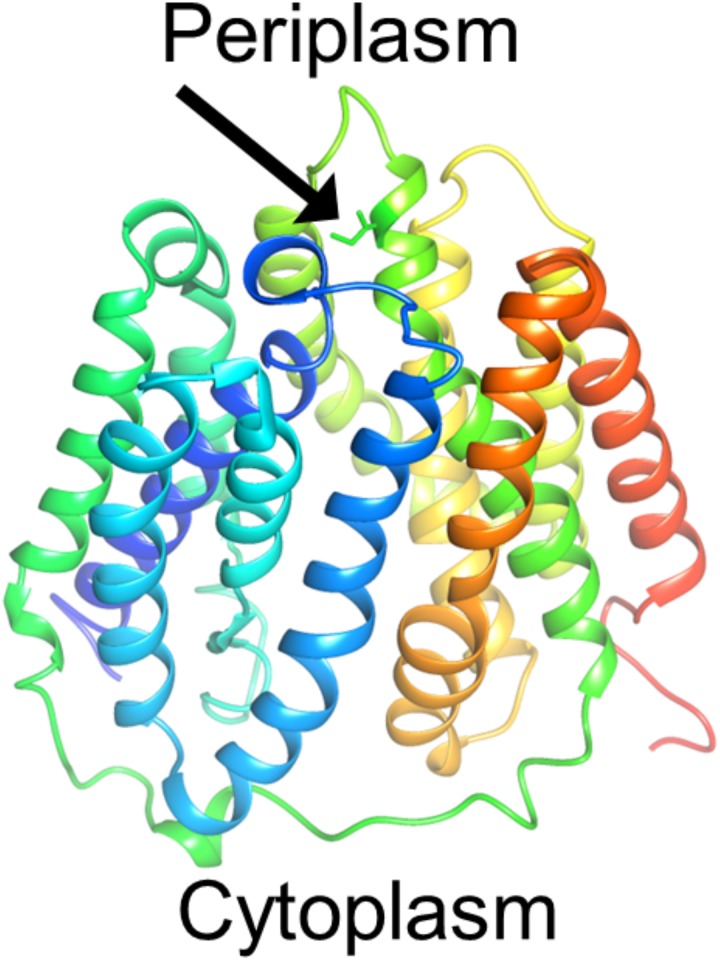
Homology model of tetA.The arrow points to the mutated residue (isoleucine 235 with side chain shown) in both traditional directed evolution and EDGE to evolve resistance to tigecycline. This mutation lies at the exit of the pump on the periplasmic side. Colors distinguish the different alpha helices for clarity. The model was created using Phyre2 with intensive mode [10].